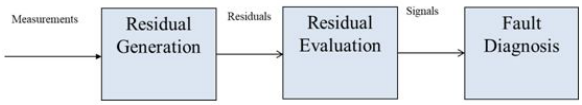
Figure 2: Basic block diagram of fault